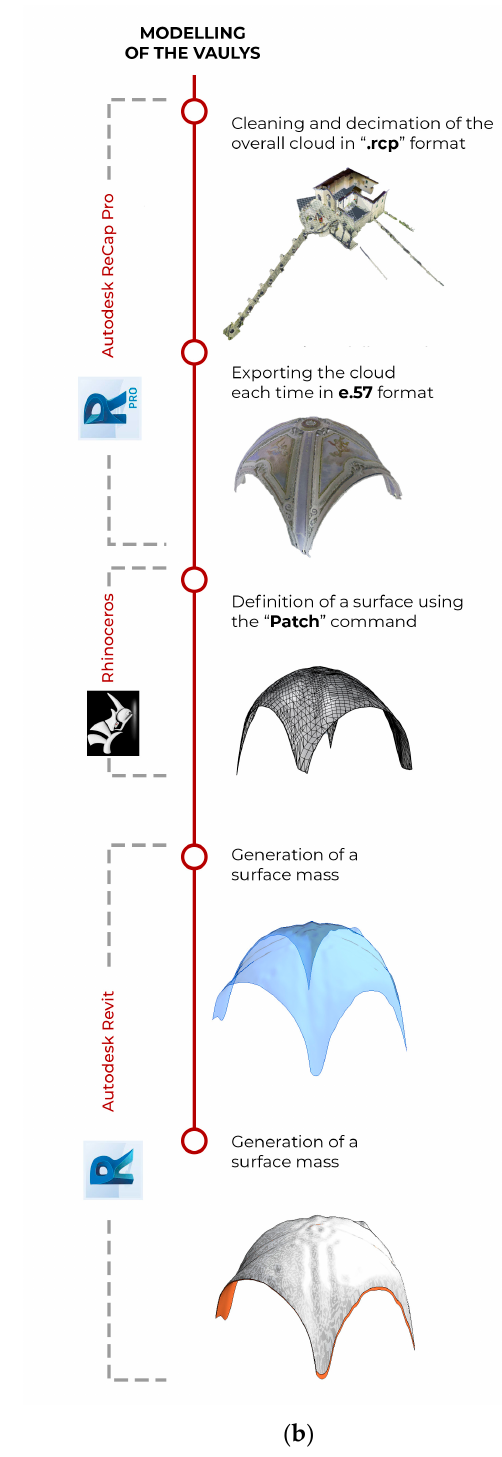
Figure 11. ( a ) Phases for the ground modelling. Terrain modelling was obtained through laser scanner survey and geo-referenced point generation from Google Earth. This stage of the process is part of the previous Figure, n 4, between 3D survey, post processing, and scan to H-BIM phases. ( b ) Generation of vault BIM objects. This workflow takes place between the post processing and scan to H-BIM phases and refers to the cleaning and modelling of complex architectural geometries for inclusion in the BIM model through a NURBS modeler. The following image details all the screen shots of this procedure.